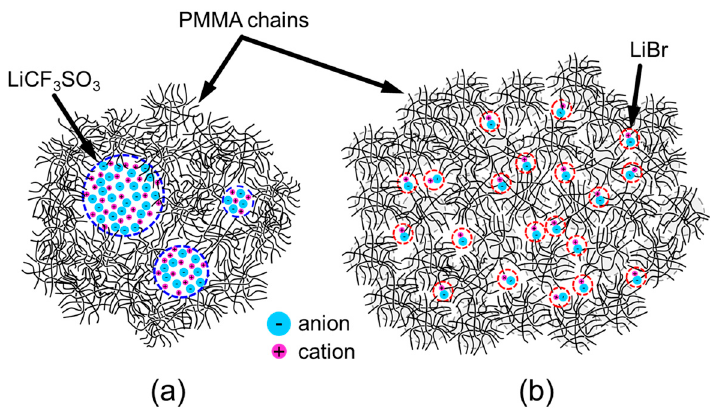
Figure 6. A schematic of the models of ( a ) PMMA/LiCF 3 SO 3 and ( b ) PMMA/LiBr with conventional lithium salts and lithium halide.